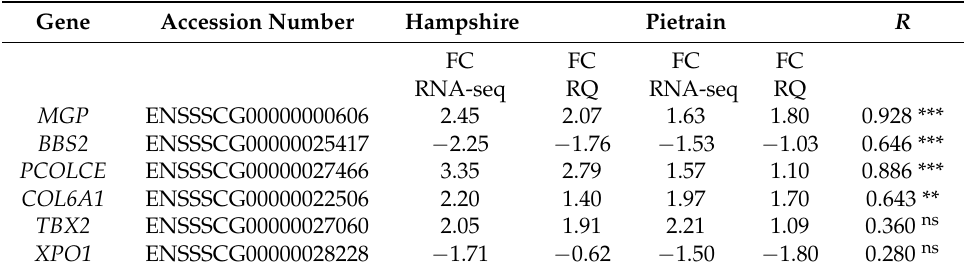
Table 5. The validation results obtained between the correlation of RNA-seq and qPCR data for differentially expressed